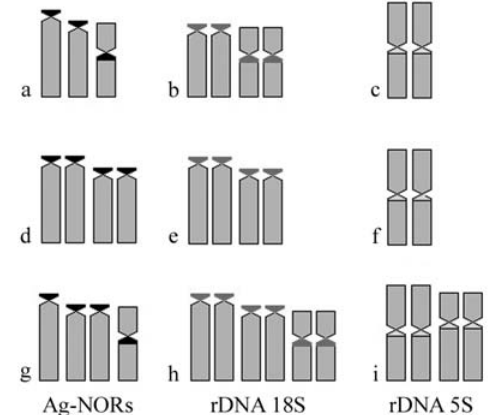
Figure 6 - Idiograms of Ag-NORs, 18S and 5S rDNA bearing chromo- somes of Prata river Hoplerythrinus unitaeniatus . (a-c) specimens with 2n = 50 chromosomes; (d-f) specimens with 2n = 51 chromosomes; (g-i) specimens with 2n = 52